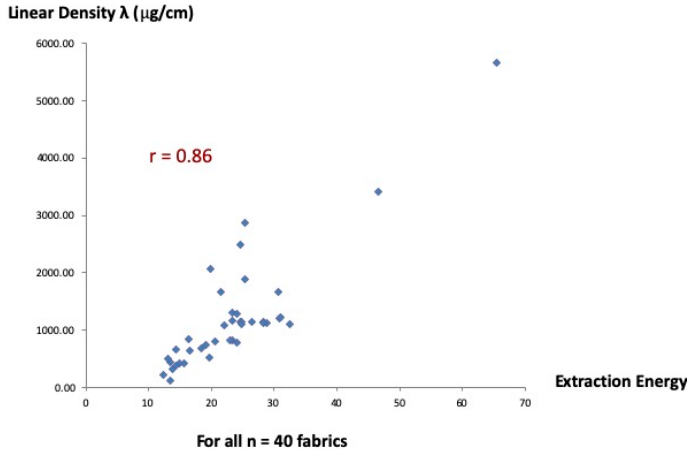
Figure 3. Fabric thickness vs. extraction energy.